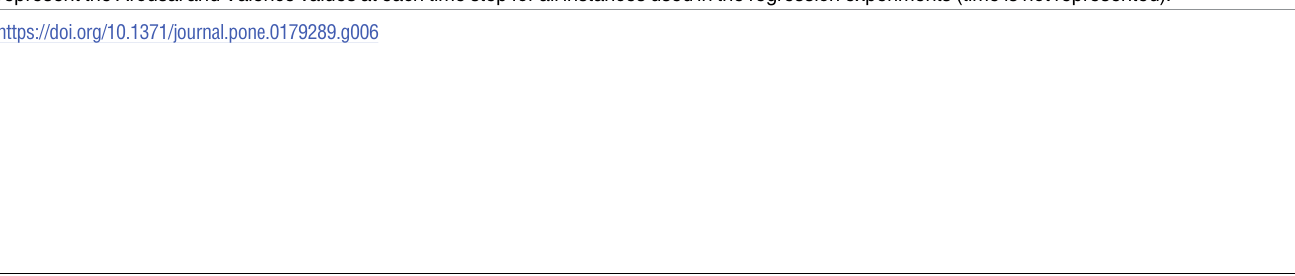
PLOS ONE | https://doi.org/10.1371/journal.pone.0179289 June 28,